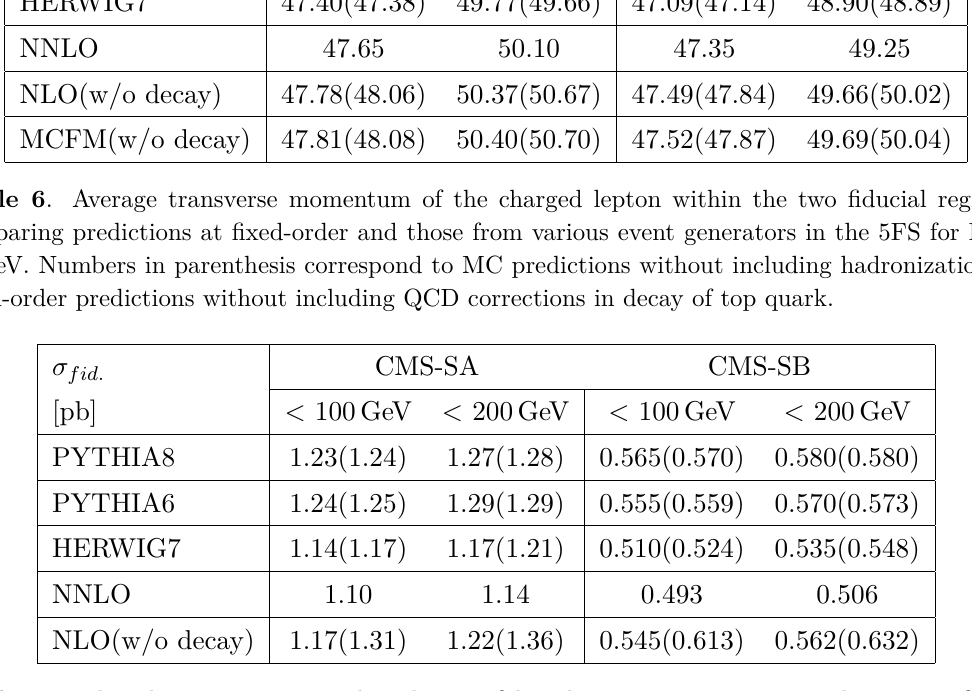
Table 7 . Fiducial cross sections within the two fiducial regions, comparing predictions at fixed- order and those from various event generators in the 5FS for LHC 13 TeV. Numbers in parenthesis correspond to MC predictions without including hadronization or fixed-order predictions without including QCD corrections in decay of top